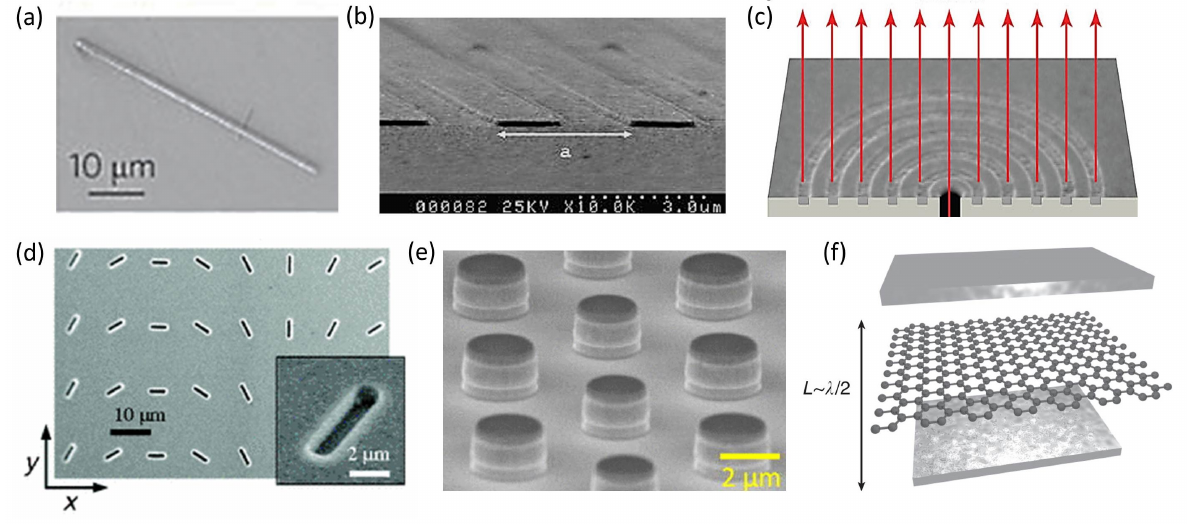
Fig. 7. Nanophotonic realizations of thermal emitters with partial spectral and spatial coherence based on photon and electron confinement effects. (a) A SiC single nanowire emitter (reproduced with permission from [110], ©NPG), (b) a periodic grating of tungsten nanoribbons (reproduced with permission from [151], ©OSA), (c) a plasmonic bulls-eye grating (reproduced with permission from [183], ©NPG), (d) an ar- ray of nanorod antennas with spatially varying local anisotropy axis (reproduced with permission from [194], ©APS), (e) a periodic photonic crystal lattice with embedded GaAs quantum wells (reproduced with permission from [71], ©AIP), and (f) a graphene sheet embedded into a planar Fabry-Perot cavity (reproduced with permission from [200],